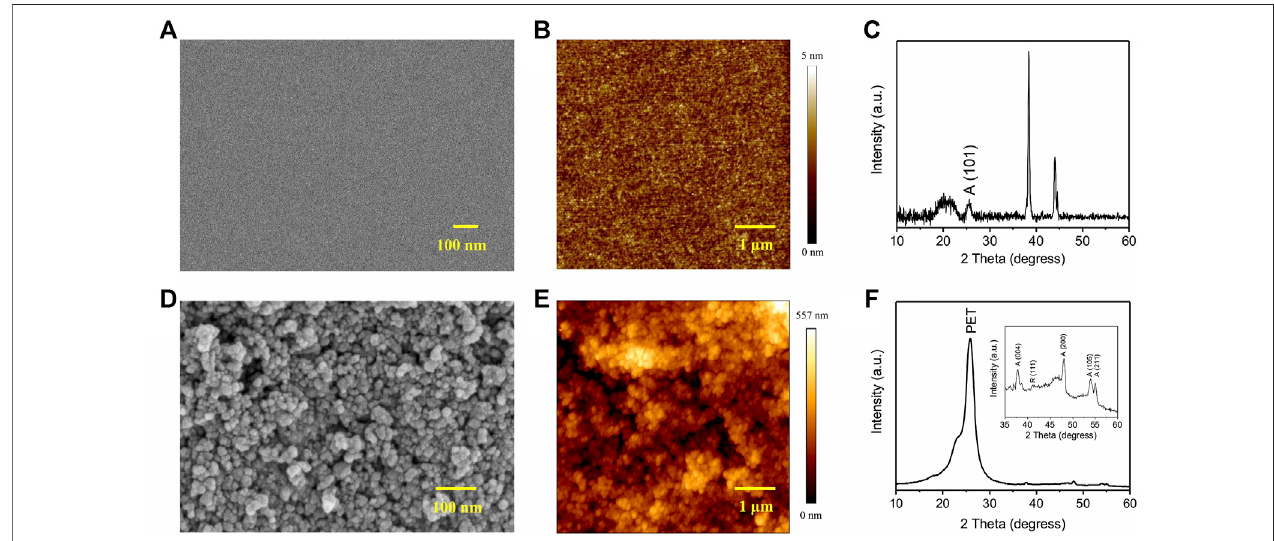
FIGURE 1 | (A,D) SEM images, (B, E) AFM images and (C, F) XRD patterns of TiO 2 fi lms on SiO 2 / p -Si (A – C) and PET (D – F) substrates prepared by route I and route II. A and R indicate anatase and rutile phases of TiO 2 .